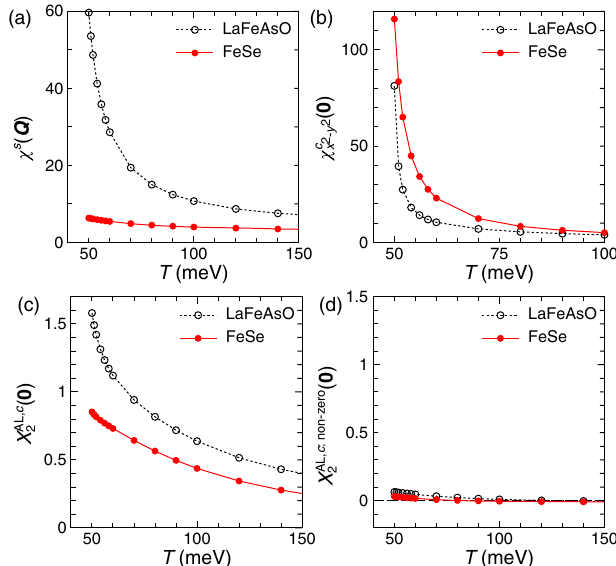
FIG. 9. (a) Spin susceptibility χ s ð Q Þ and (b) orbital suscep- tibilities χ c ð 0 Þ for FeSe and LaFeAsO as functions of T . We x 2 − y 2 put r ¼ 0 . 25 for FeSe and r ¼ 0 . 41 for LaFeAsO. (c) X AL ;c 2 ð 0 Þ and (d) X AL ;c ∶ non − zero 2 ð 0 Þ for FeSe and LaFeAsO.